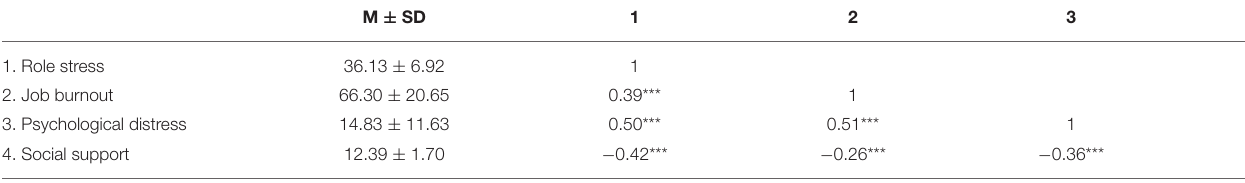
TABLE 1 | Descriptive statistics and correlations among variables.